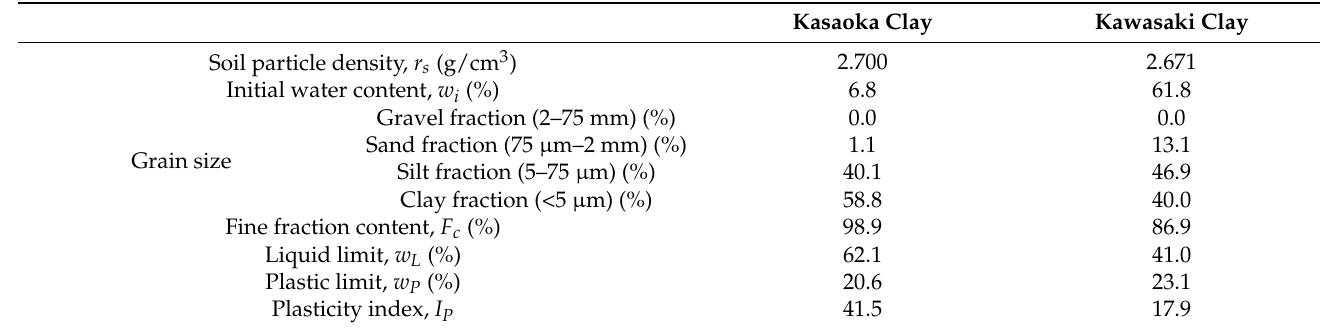
Table 2. Physical properties of